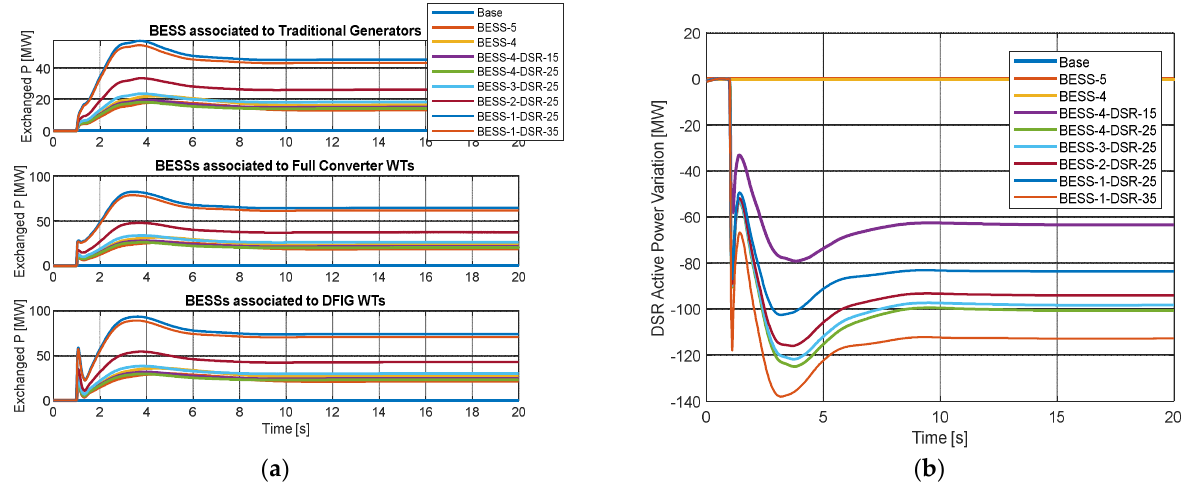
Figure 10. High Import DP, generation outage of 817 MW: ( a ) power exchanged by BESSs (positive means export, negative means import); ( b ) total power consumption variation provided by DSR.